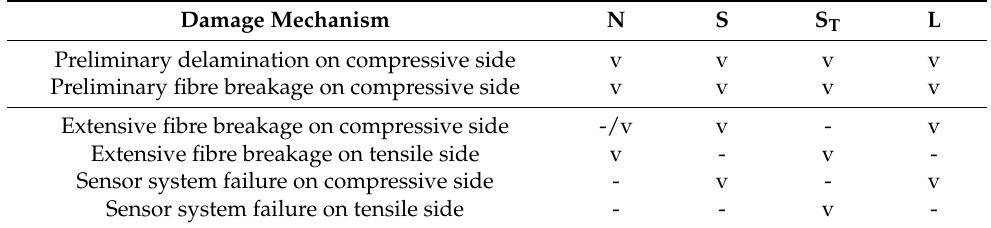
Table 1. Damage mechanisms as registered during four-point bending. ‘v’,’-/v’ and ‘-’ signify that the mechanism is found in the bulk of specimens, in a single specimen or not at all,